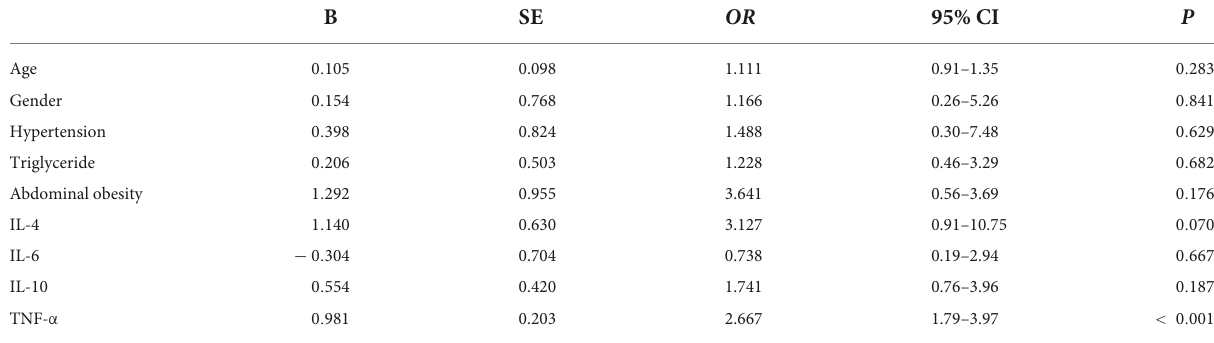
TABLE 4 Logistic analysis after adjusting for sex, age, hypertension, obesity, and interleukin (IL)-10, IL-4, and IL-6 levels. B SE OR 95%